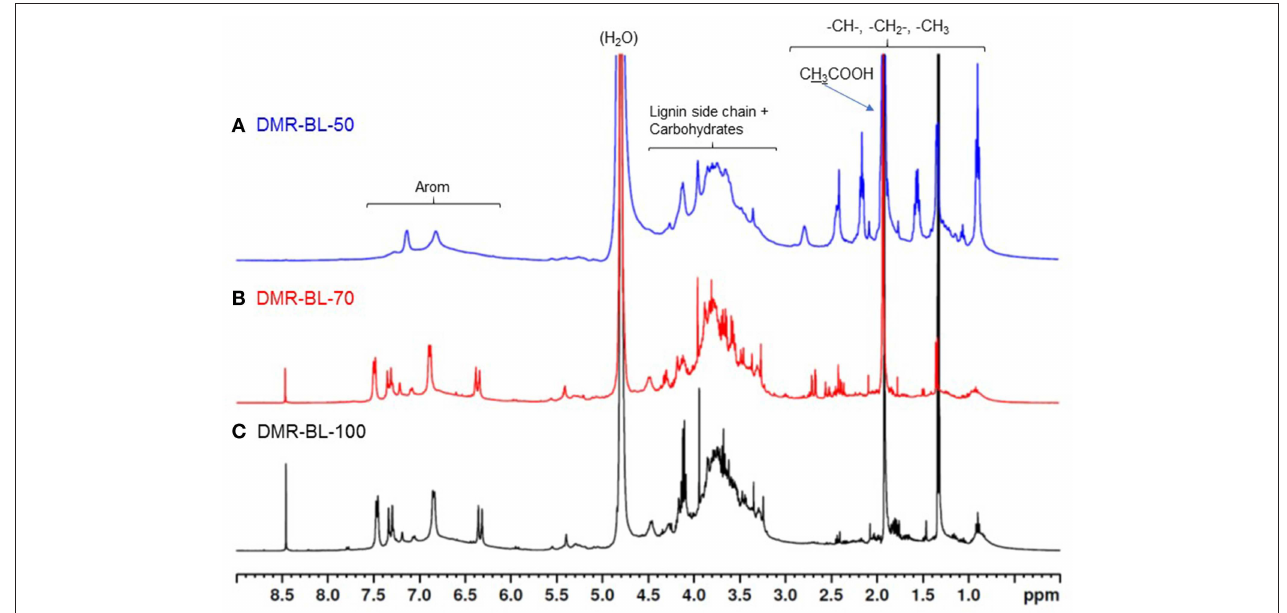
FIGURE 3 | HSQC NMR spectra of three black liquor samples. (A) DMR BL-50, (B) DMR BL-70, and (C) DMR BL-100. H, p -hydroxyphenyl; G, guaiacyl; S, syringyl; A, β -aryl ether ( β -O-4); p CA, p -coumarate; FA, ferulate.